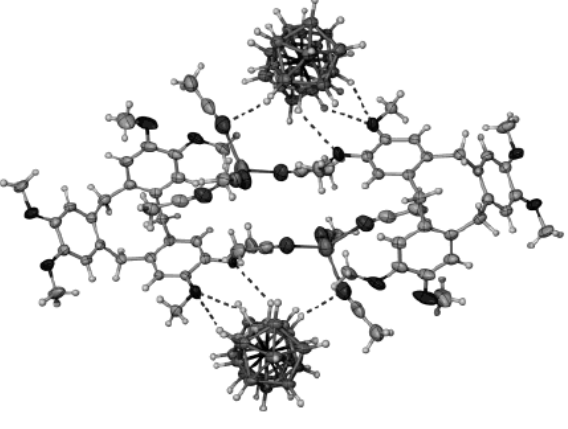
Figure 115. X-ray structure of {([Ag(MeCN)4] + ∩ CTV)[3,3-Co(1,2-C 2 B 9 H 11 ) 2 ]} 2 . Reprinted with permission from reference [122]. Copyright © (2003) American Chemical Society.